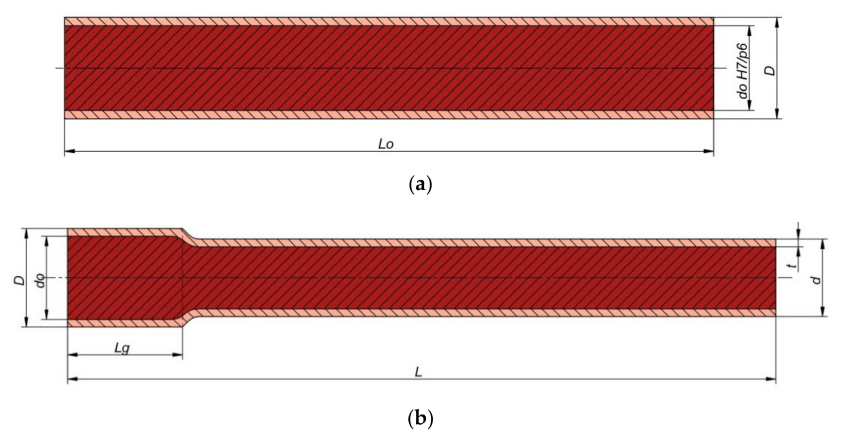
Figure 2. Shape and dimensions of ( a ) billets for rolling bimetallic rods and ( b ) a finished bimetal- lic